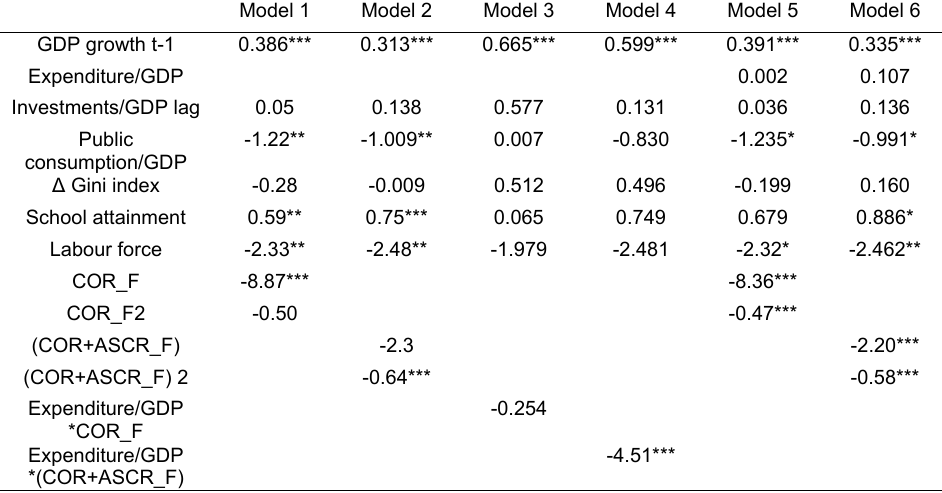
Table 4. Estimates of Equation